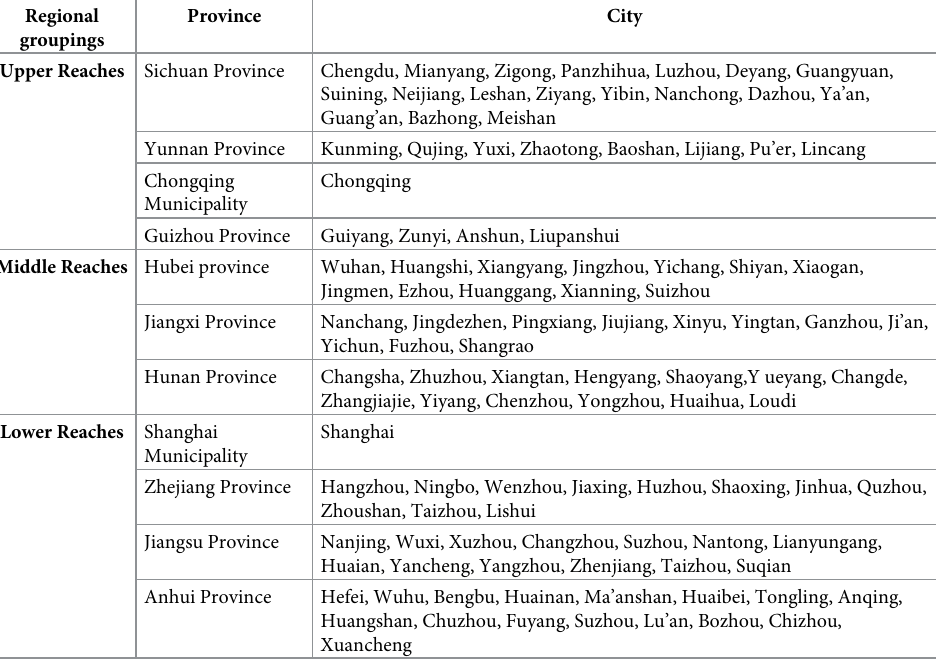
Table 3. City grouping of Yangtze River Economic